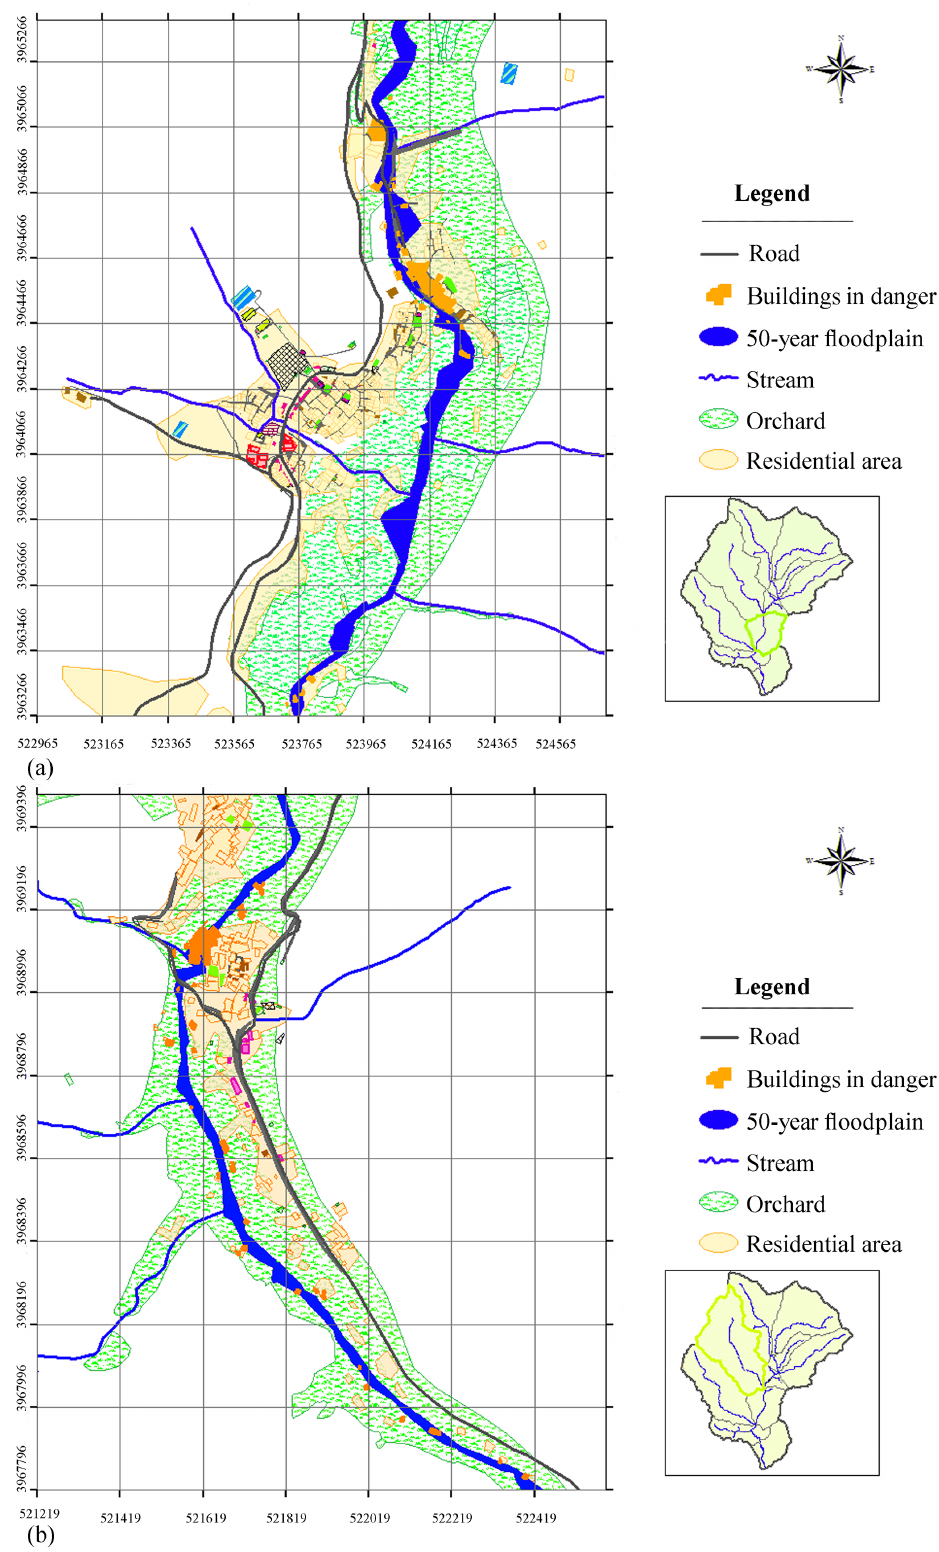
Figure 5. The 50-year floodplain in the subbasins of (a) Sulaghan and (b) Sangan (the original layers are obtained from WRI,